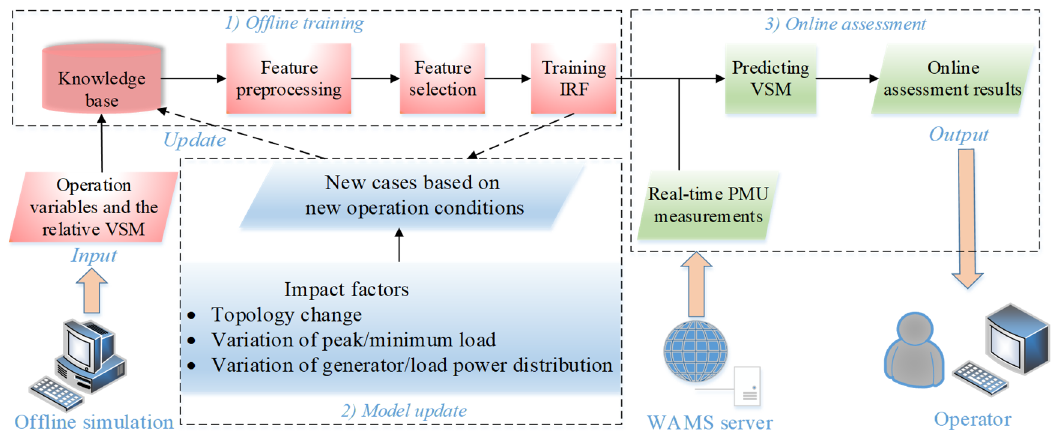
Figure 3. Proposed framework for online voltage stability margin (VSM)